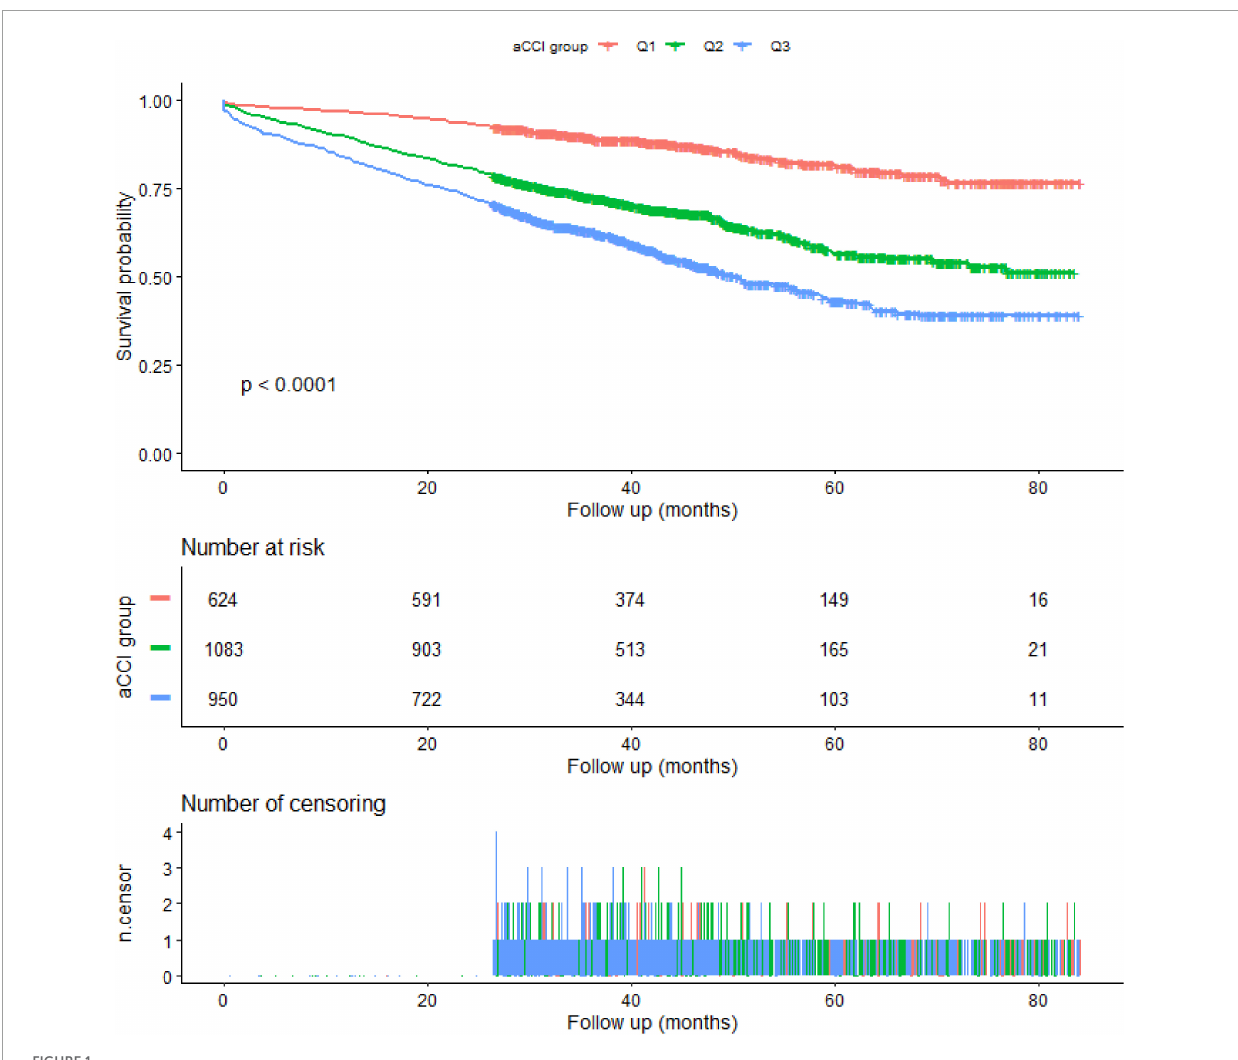
FIGURE1 The Kaplan–Meier survival